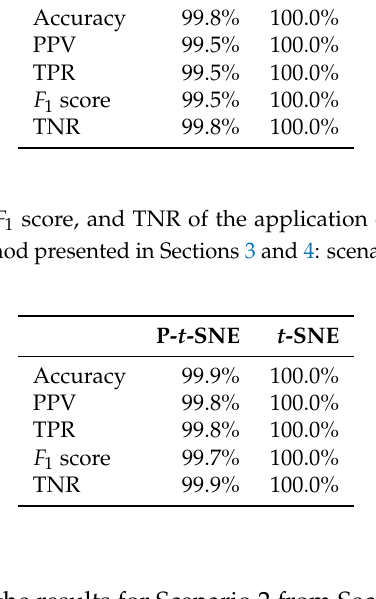
Table 3. Accuracy, PPV, TPR, F 1 score, and TNR of the application of P- t -SNE and t -SNE damage detection and classification method presented in Sections 3 and the 4: scenario 1 and the majority voting approach. P- t -SNE t -SNE